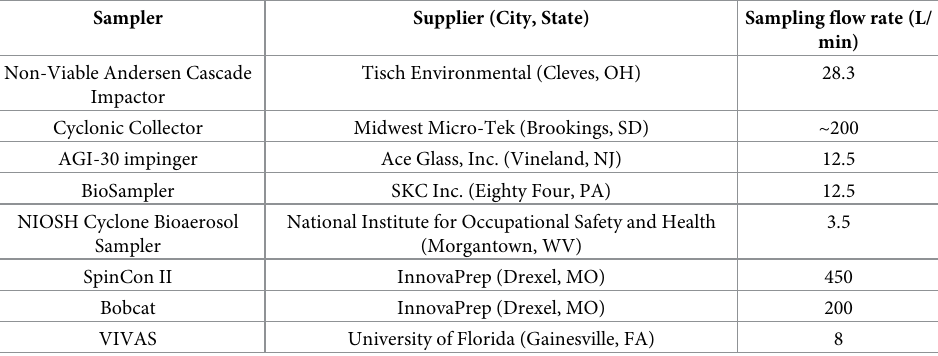
Table 1. Air samplers evaluated in tests using artificially generated viral aerosols, with the sampling airflow rate for